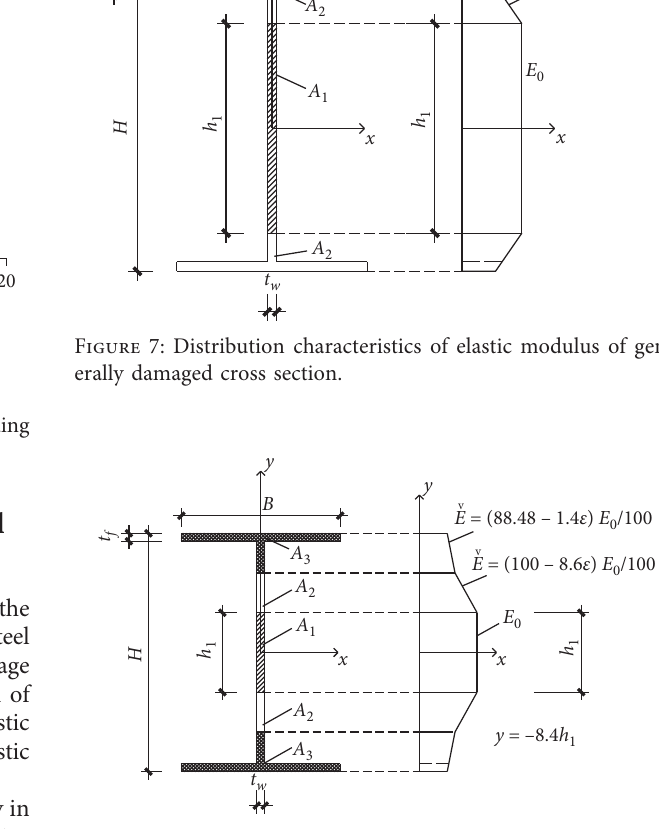
Figure 8: Distribution characteristics of elastic modulus of seri- ously damaged cross